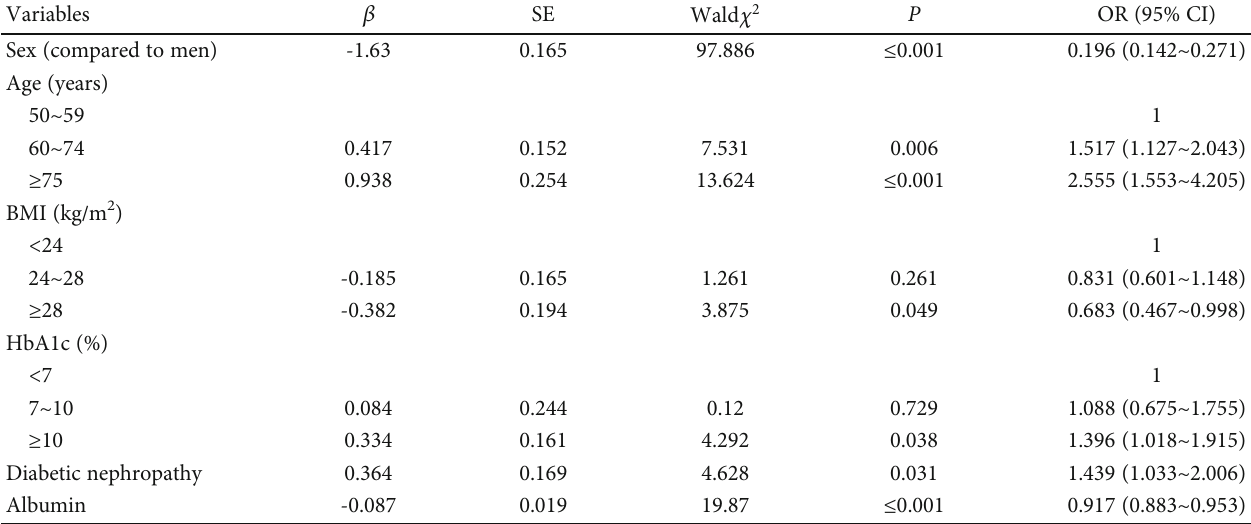
Table 5: The risk factors for sarcopenia in diabetes, estimated using multivariable logistic regression